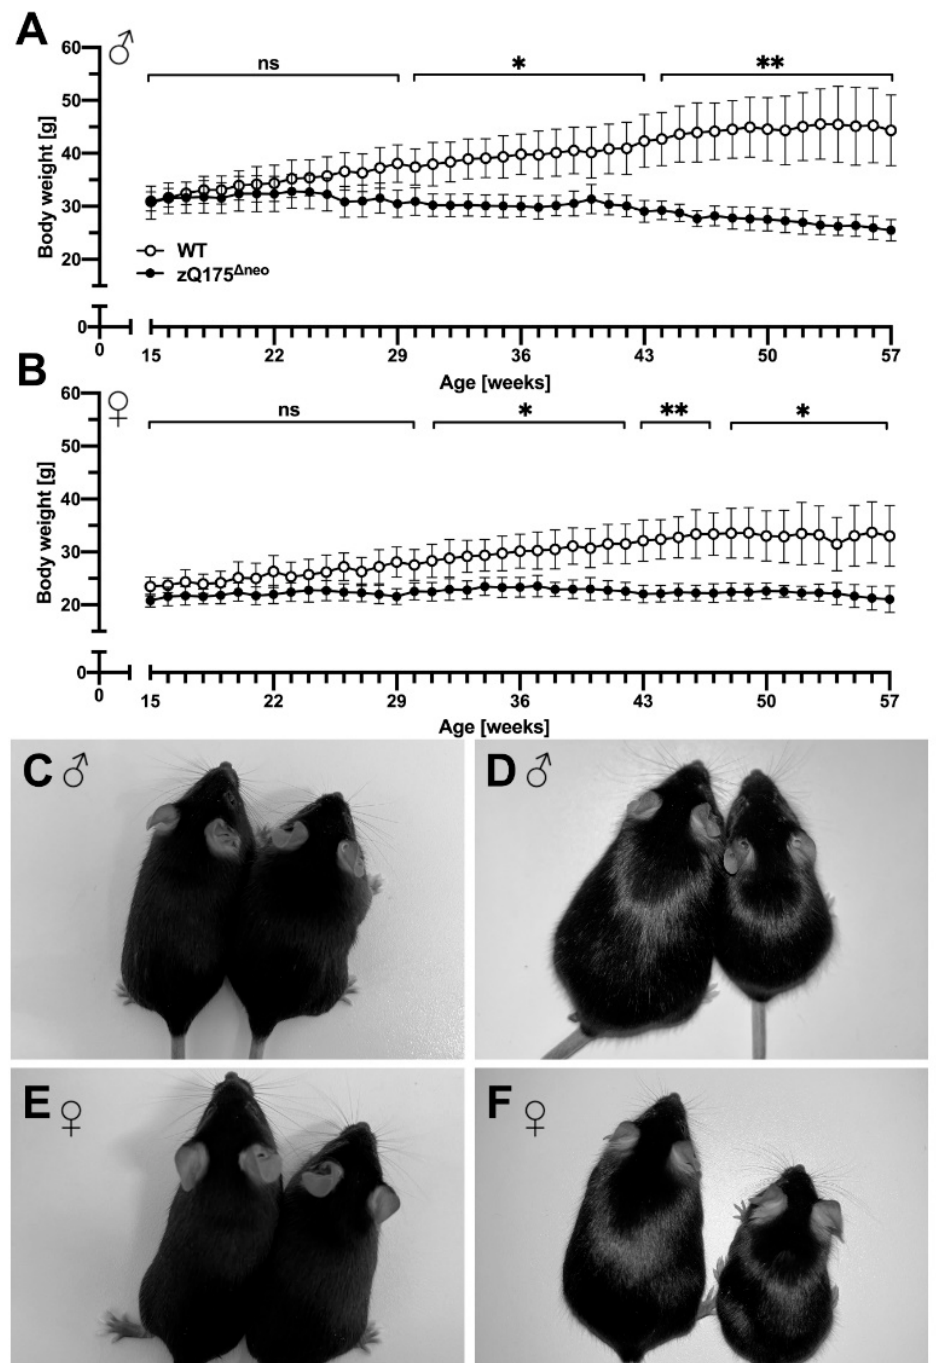
Figure 2. The zQ175 Δ neo mice display a significantly reduced weight gain in the first weeks compared to WT littermates. Later on, increasing weight loss is appreciable. ( A , B ) The body weight of male ( A ) and female ( B ) WT ( ○ ) and zQ175 Δ neo mice ( ● ) was measured weekly from 15 to 57 weeks of age. Data are presented as mean ± standard deviation (SD); N = 6. Significance was calculated using multiple unpaired t -tests followed by Holm-Šídák correction and is indicated as ns: not significant, *: p ≤ 0.05, and **: p ≤ 0.01. ( C – F ) Representative images showing a direct comparison of 15-week-old ( C , E ) and 57-week-old ( D , B ) male ( C , D ) and female ( E , F ) WT (left) and zQ175 Δ neo (right) mice.